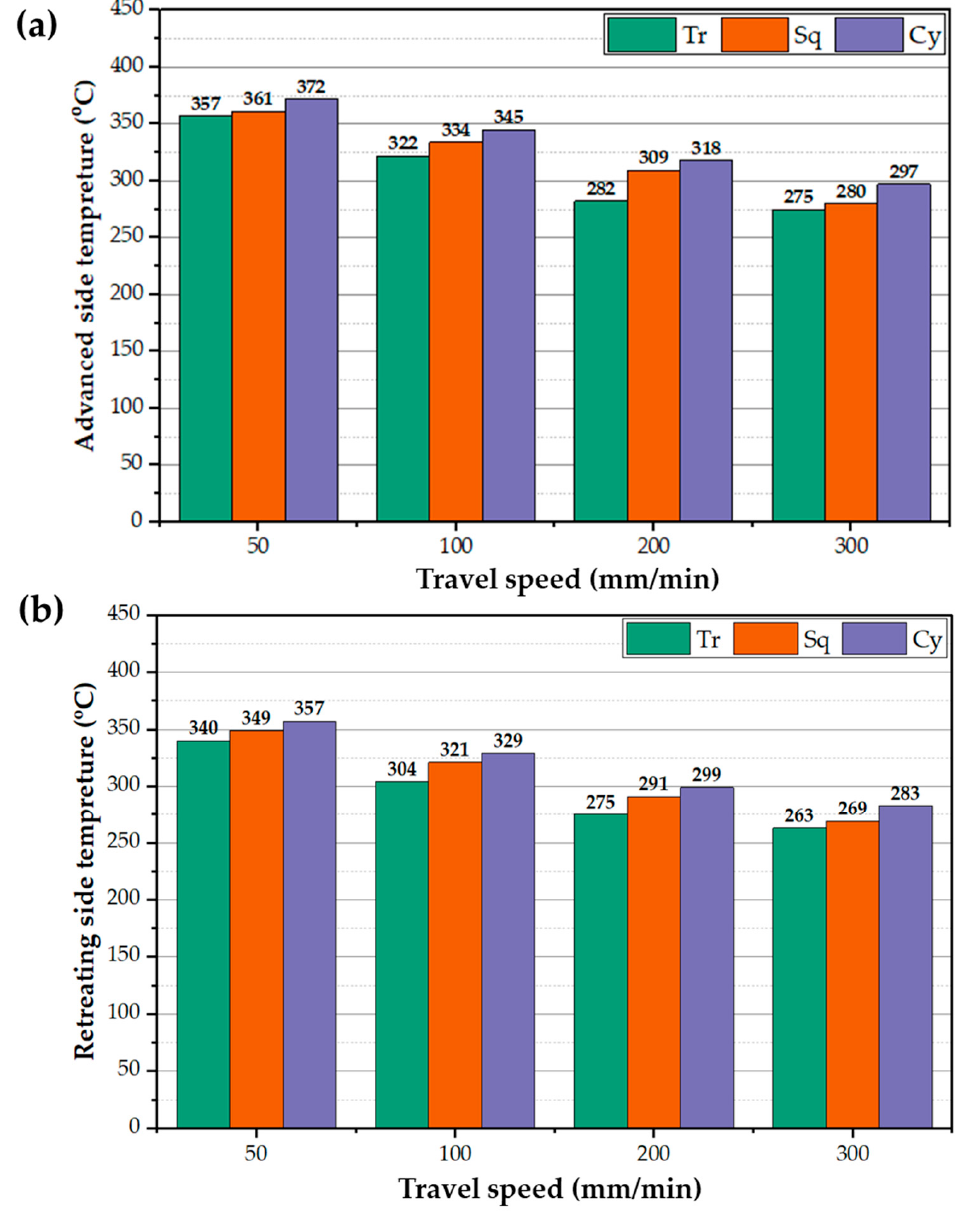
Figure 8. Peak temperatures of ( a ) AS and ( b ) RS for the BT-FSPed AA1050 at a constant rotation speed of 600 rpm and different travel speeds of 50, 100, 200, and 300 mm/min using Tr, Sq, and Cy pin geometries.